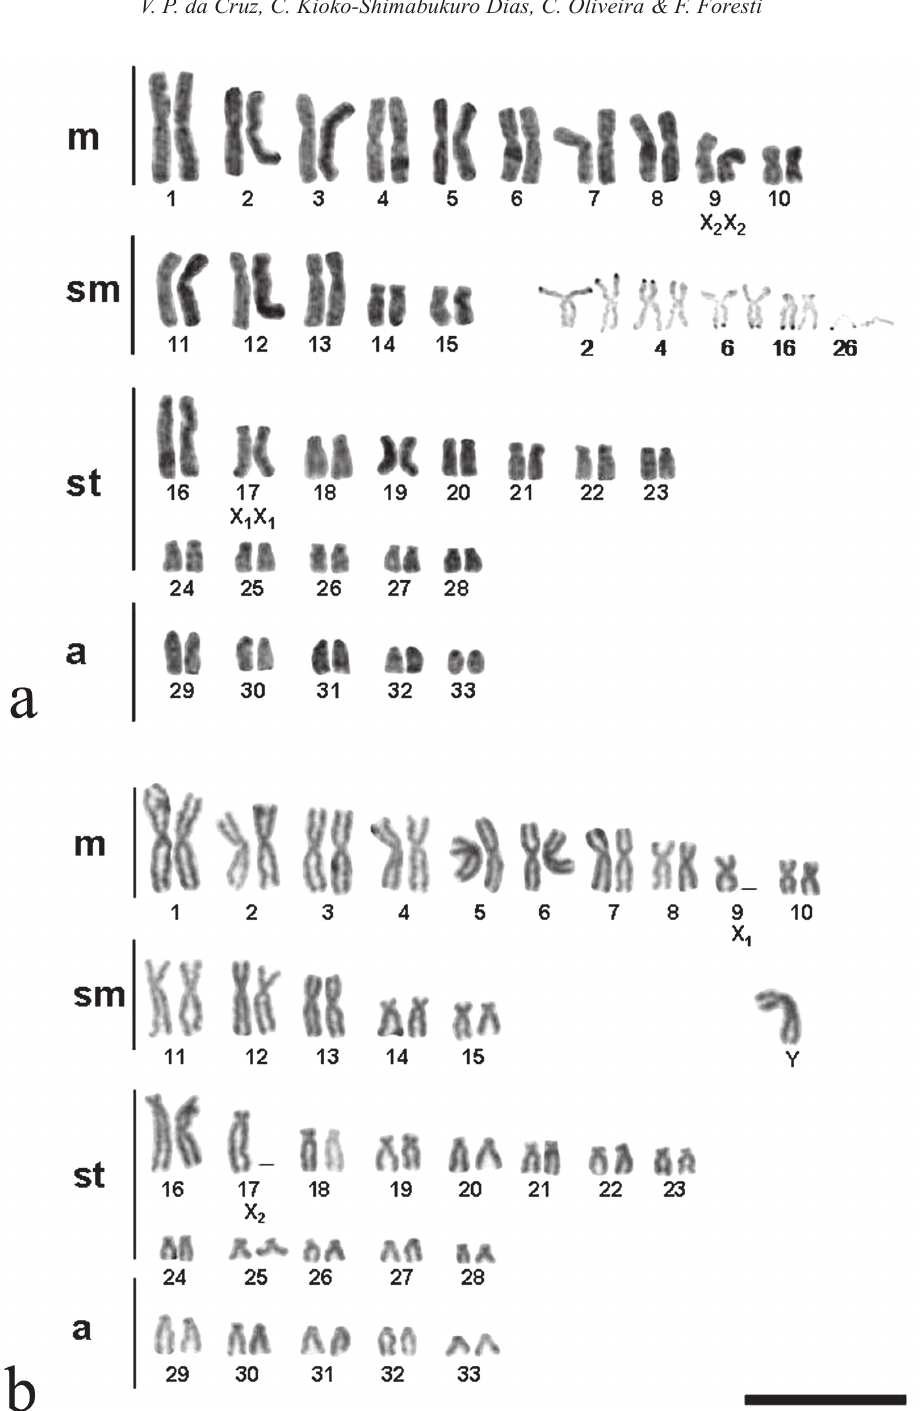
Fig. 2. Karyotypes of female ( a ) and male ( b ) of Potamotrygon aff. motoro sample from Porto Rico, highlighting the sex chromosomes after conventional and the chromosomes marked by NOR. Scale bar = 10 